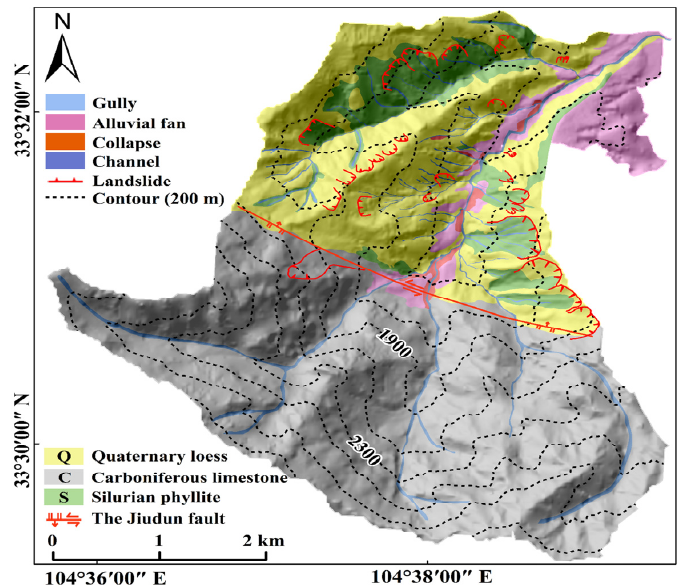
Figure 1. Location of the study area. ( a ) Location of the Bailong River basin; ( b ) location of the Wen- chuan earthquake epicenter; ( c ) location of the GLP (the optical image was produced in 2019).